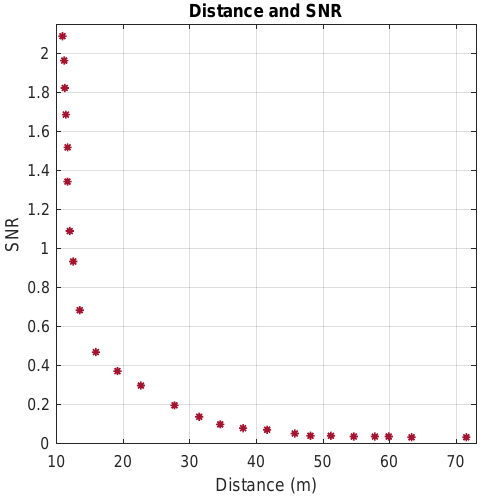
Figure 12. The Relationship between SNR and Distance